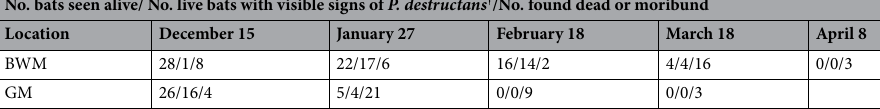
Table 1. Progress of white-nose syndrome (WNS) in bats from Wisconsin introduced into bat-free hibernacula in Vermont with histories of WNS outbreaks. WNS was first recorded at BWM mine late in the previous winter. WNS was present at GM during the 2 previous winters, after which most bats had died. † As determined by high-resolution